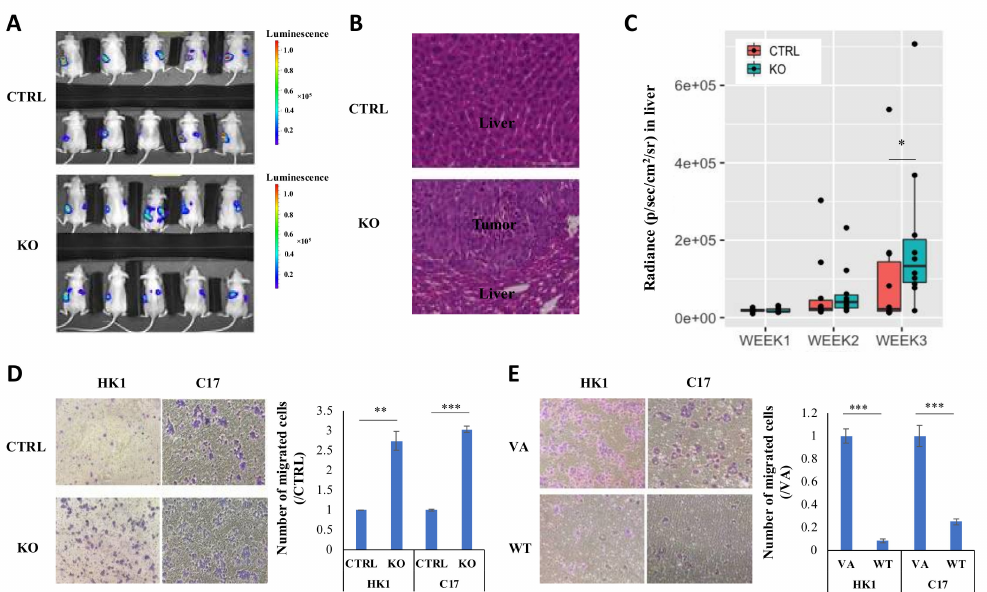
Figure 3. CYLD inhibits NPC metastasis in vivo and migration in vitro . ( A ) HONE-1-luc cell line with CYLD knockout / control were intrasplenically injected into nude mice (ten mice per group). The third-week bioluminescent signal was assessed by the IVIS Spectrum system as shown. ( B ) H and E staining was performed to confirm the tumor metastasis to liver. One liver from the control group and one liver from the knockout group under 20 × magnification are shown. Scale bar = 100 µ m. ( C ) Bioluminescence signals from control and CYLD knockout were quantified weekly. Radiance of mice in both groups are represented in box plots. RStudio was used to draw the box plot. The signal in the knockout group is significantly higher than in the control group. ( D ) Boyden chamber migration assay was performed in both HK1 and C17 cells with CYLD knockout / control. ( E ) CYLD overexpression / VA. Representative images under 10 × magnification and the quantitative bar graphs show the normalized migrated cell numbers. The data shown are represented as the mean ± standard deviation (SD).